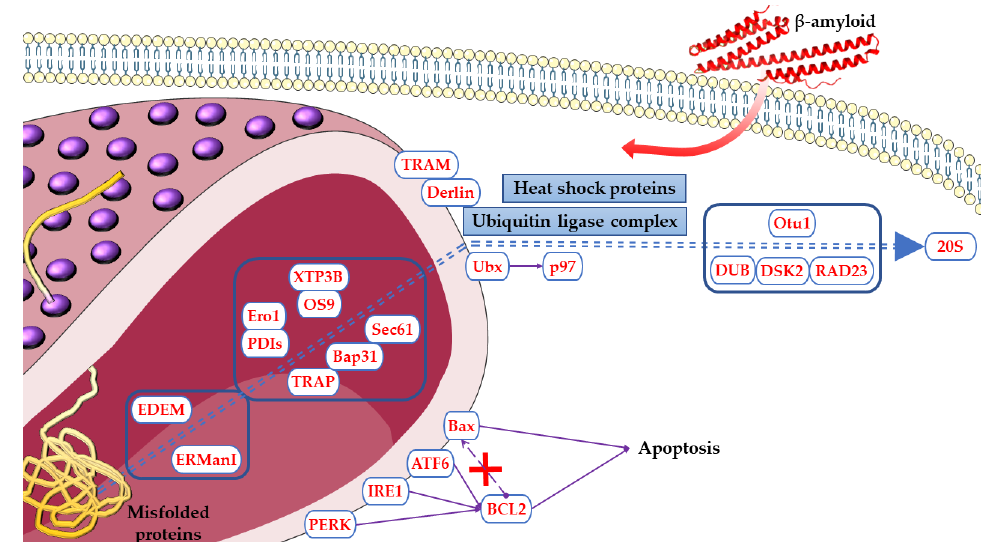
Figure 5. Proteins encoded by DEGs modulated in Aβ 1-42 and Δ 8 -THC treated cells in ER pathway. The name of the shown proteins was obtained by KEGG. The figure was drawn using the vector image bank of Servier Medical Art by Servier (http://smart.servier.com/, accessed on 10 February